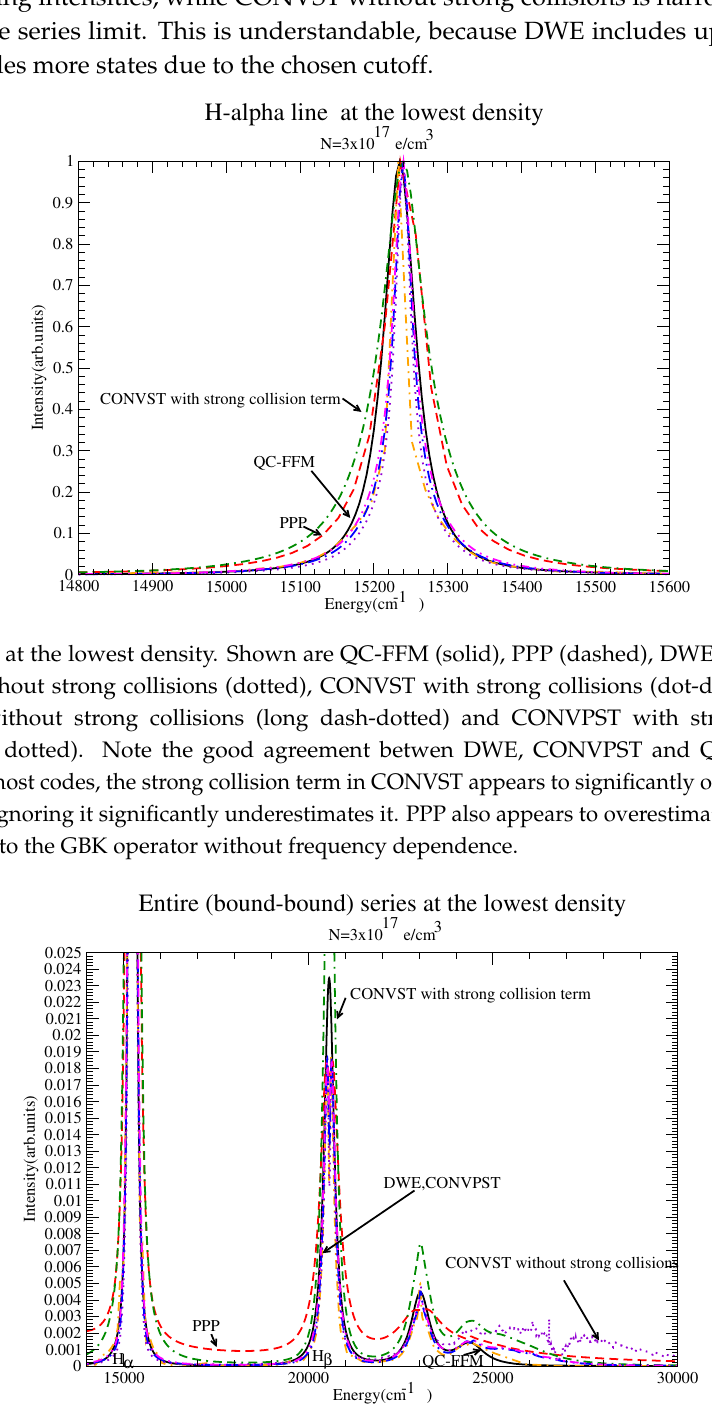
Figure 11. Comparision of line widths. Shown are QC-FFM (solid), PPP (dashed), DWE (dash-dotted), CONVST without strong collisions (dotted), CONVST with strong collisions (dot-double dashed), CONVPST without strong collisions (long dash-dotted) and CONVPST with strong collisions (dash-double dotted). It is clear that PPP is widest, probably due to the GBK operator; among the remaining codes it is also clear that the strong collision term adopted by CONVST is too large. We also note that QC-FFM does not display the characteristic dip in the H β center, but this is a known and expected artifact of QC, with little effect on the